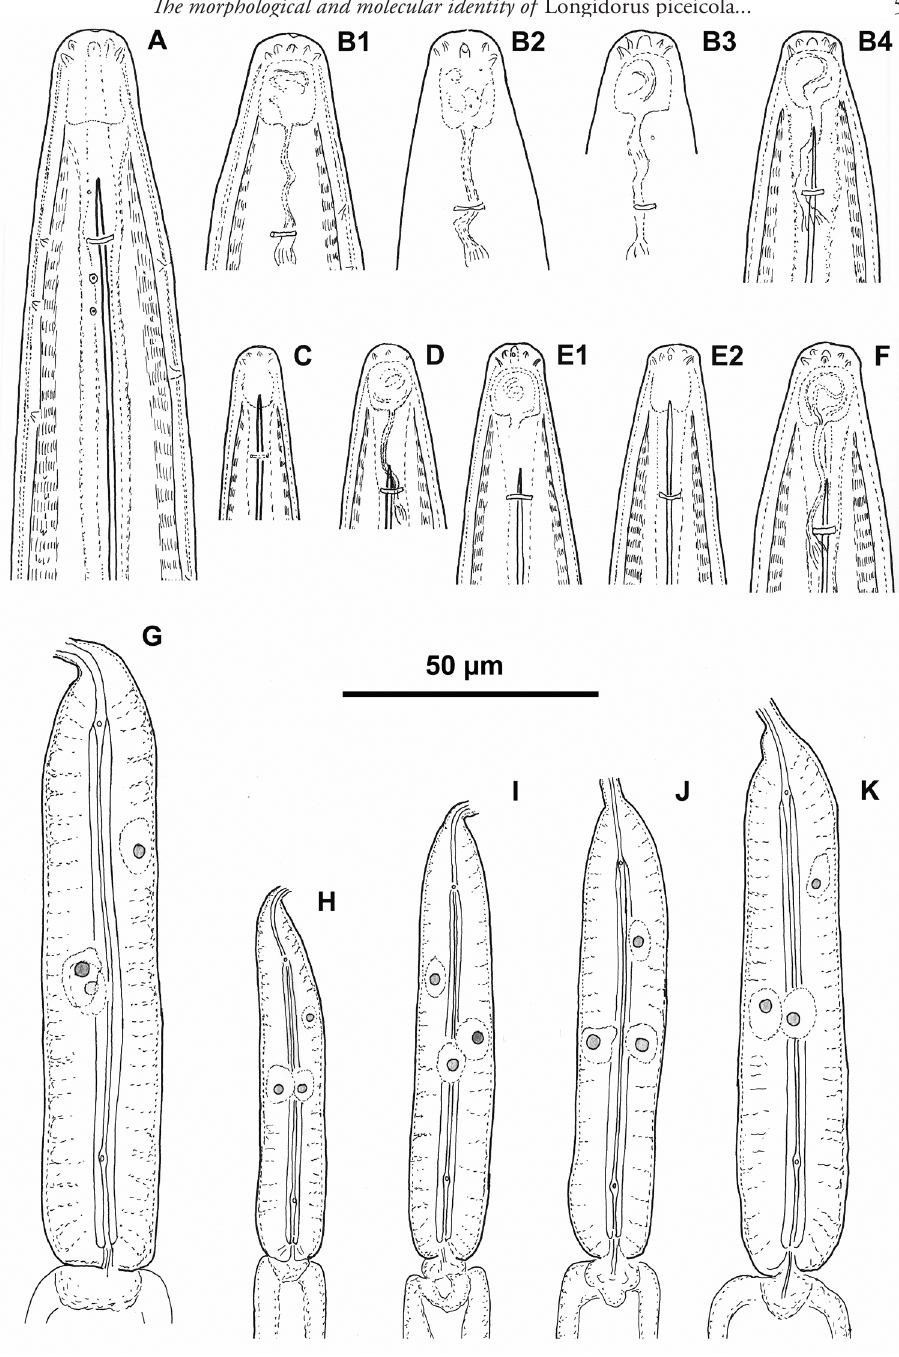
Figure 1. Longidorus piceicola Female and juveniles: A Neck region – female B1–B4, C Head end with amphidial fovea B1–B3 females, B4 juvenile 4 th stage ( B2 right and B3 left) C, D, E1, E2, F Anterior ends of first- to fourth-stage juveniles G–K Pharyngeal bulb of female ( G ) and first- to fourth-stage ju- veniles ( H–K